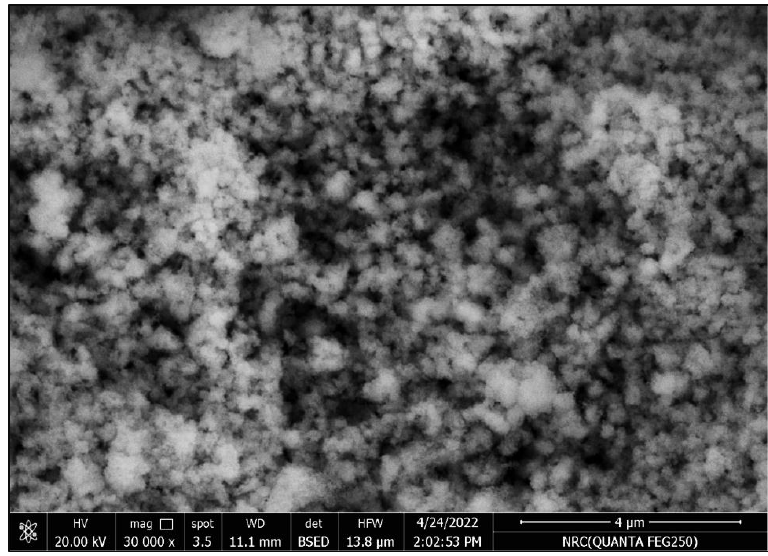
Figure 3. Scanning electron microscope (SEM) micrograph of ZnO NPs.